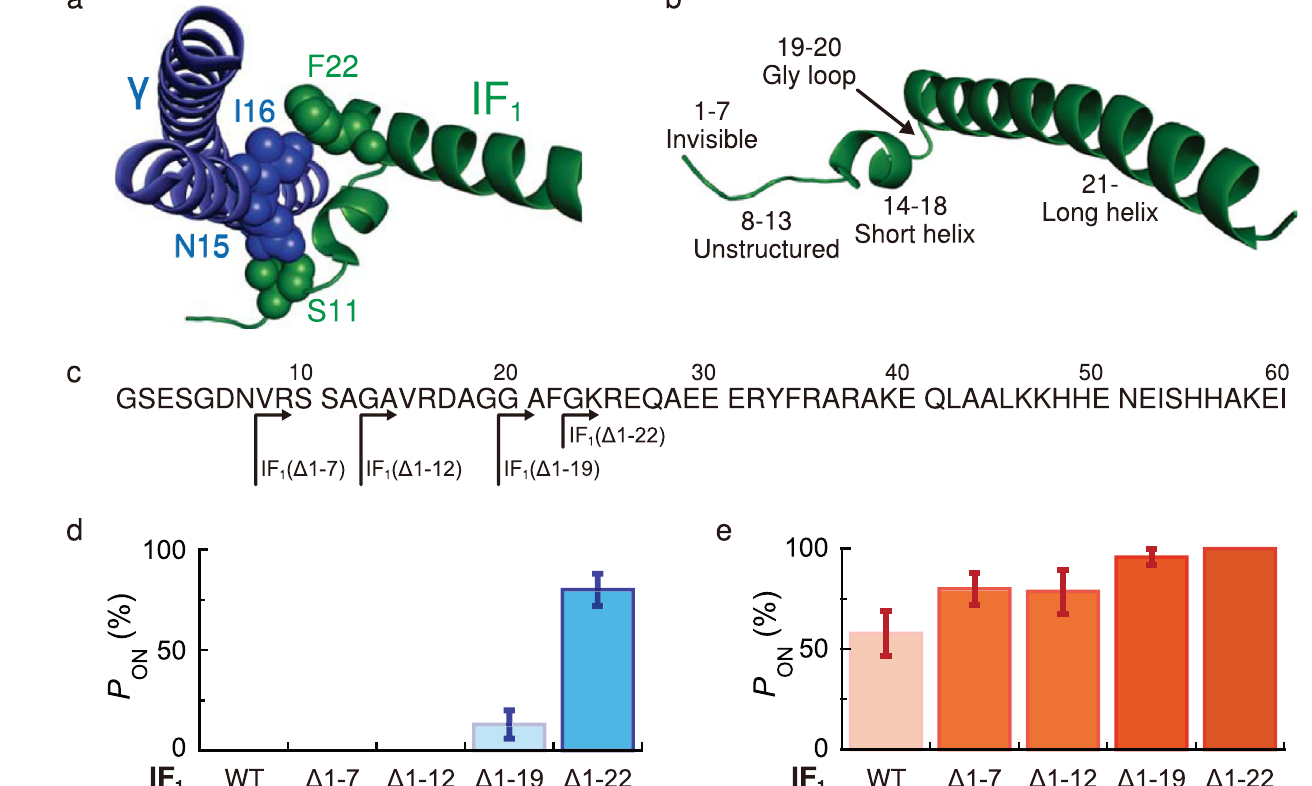
inhibited b MF 1 by mutant IF 1 s after d counterclockwise and e clockwise manip- ulation. Experiments were performed under 100 μ M ATP, 100 μ M ADP, and 1mM P i . The data for IF 1 (WT)are also plottedfor comparison (Fig. 3b).Values represent reactivation probability ( P ON ) ± SD. P ON was de fi ned as the probability of an ON ffiffiffiffiffiffiffiffiffiffiffiffiffiffiffiffiffiffiffiffiffiffiffiffiffiffiffiffiffiffiffiffiffiffiffiffiffiffiffiffiffi p , event against total molecules. The SD of P ON is given as P ON ð 100 (cid:2) P ON Þ = N where N is the number of total molecules ( N = 11 – 25 molecules). Source data and the exact number of molecules in each data point are provided in the Source Data fi